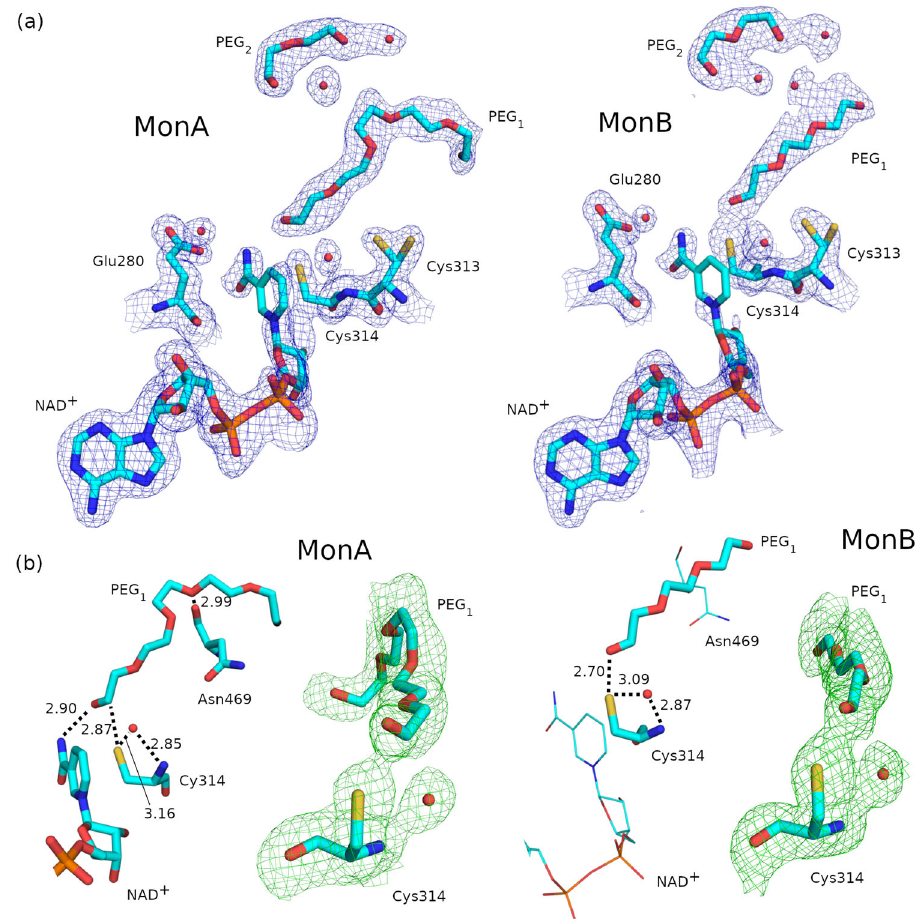
Fig. 5 Cofactor and substrate structures in the ALDH1A3-NAD + complex (PDB code 7QK8). a 2Fo – Fc electron density maps contoured at σ = 1 over Cys313, Cys314, Glu280, NAD + , PEG1, PEG2 and water molecules inside the cofactor and substrate-binding pockets. b For monomers A and B, hydrogen bonds of Cys314, Asn469 and NAD + with PEG1, and polder OMIT maps at σ = 3.5 over Cys314 and PEG1. A highly conserved water molecule near Cys314 is depicted in red. The parts of the structure depicted with thin lines in monomer B represent those no longer interacting with the PEG1 molecule, with respect to monomer